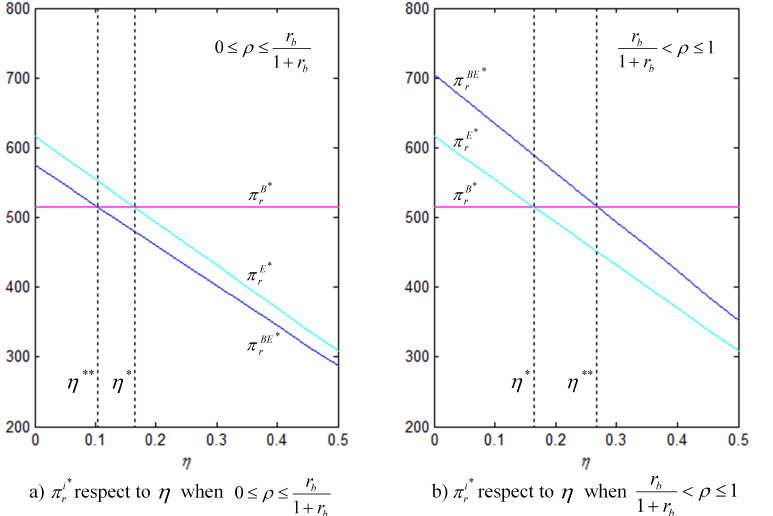
Figure 10. Comparison of the optimal π m under three financing strategies ( θ = 5, r b = 0.2).